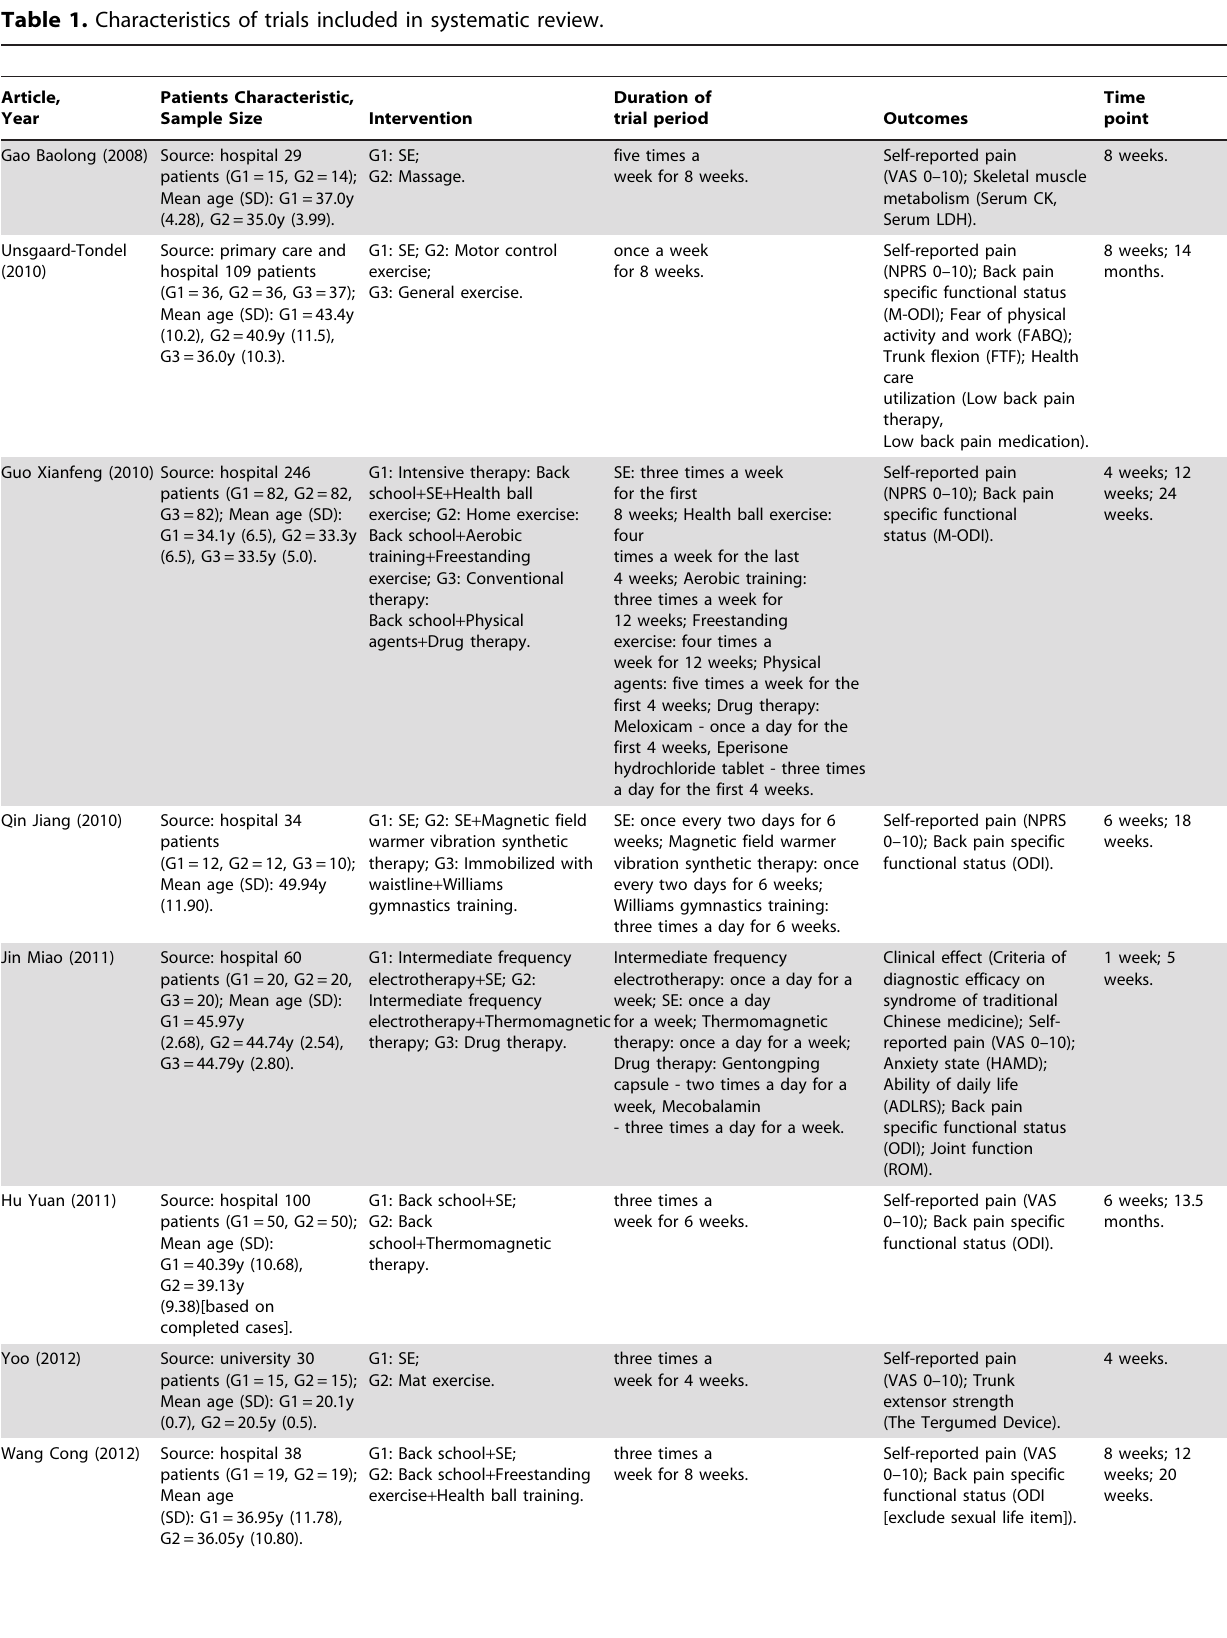
Table 1. Characteristics of trials included in systematic review.